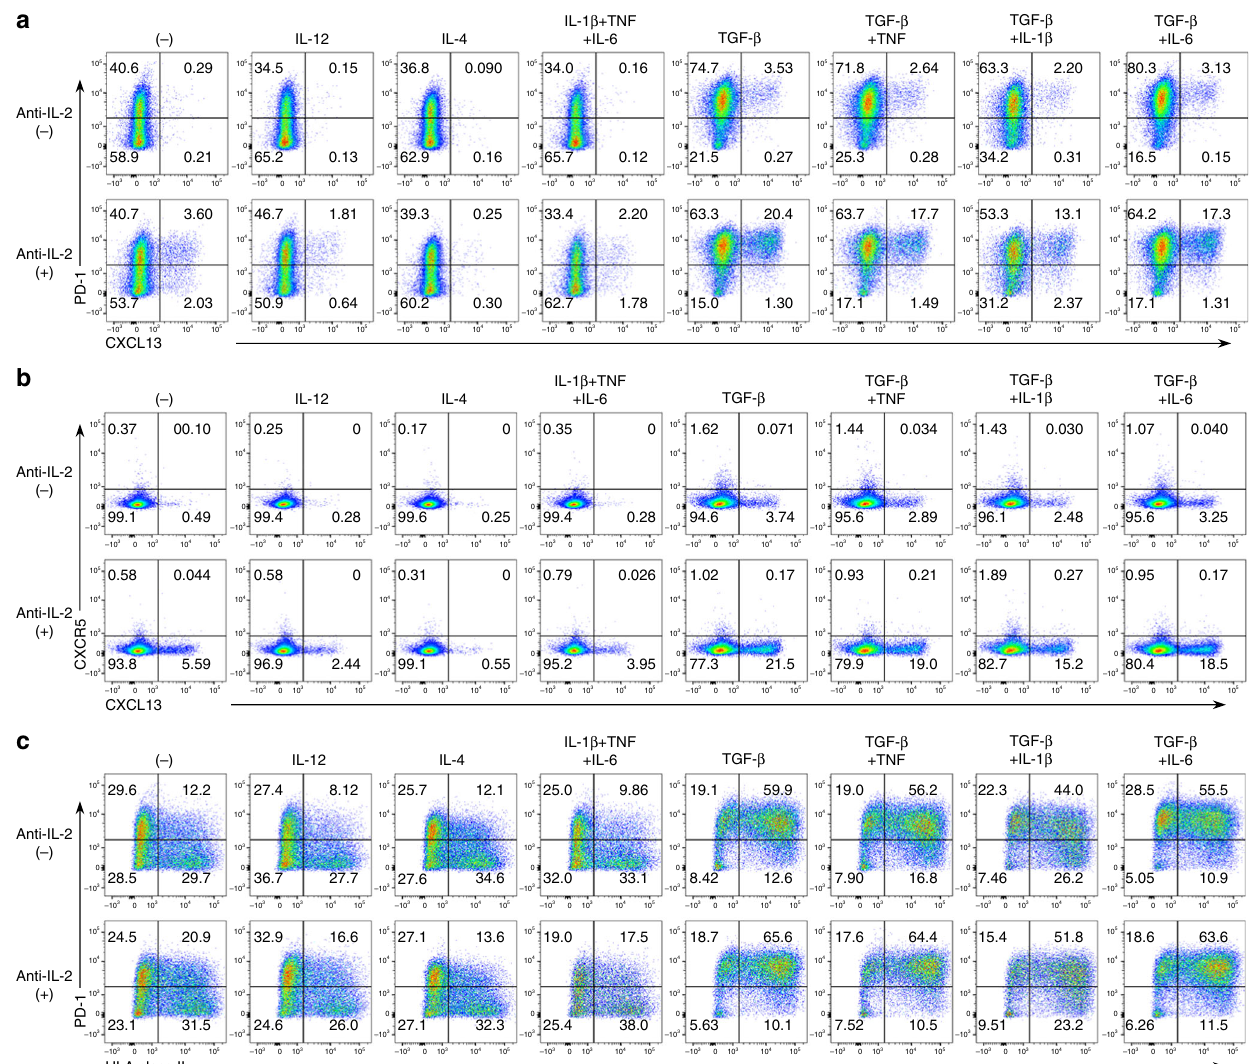
Fig. 1 TGF- β -positive, IL-2-limiting conditions give rise to CXCL13-producing PD-1 hi CXCR5 - CD4 + T cells in vitro. a – c Healthy human naive CD4 + T cells were differentiated with TCR stimulation and the indicated cytokines in the presence or absence of neutralizing anti-IL-2 antibody for 5 days. Representative dot plots of PD-1 and intracellular CXCL13 ( a ), CXCR5 and CXCL13 ( b ), and PD-1 and HLA class II ( c ) are mock-transduced CD4 + T cells (Fig. 3a). The expression of CXCL13 messenger RNA in sorted Sox4-transduced CD4 + cells was about 35 times higher than that in sorted mock-transduced cells (Fig. 3b). Furthermore, lentiviral knockdown of Sox4 in Analysis of domain functions in SOX4/CXCL13 axis . Sox4 naive CD4 + T cells signi fi cantly downregulated CXCL13 induc- logical signi fi cance of Sox4 in CXCL13 production by human